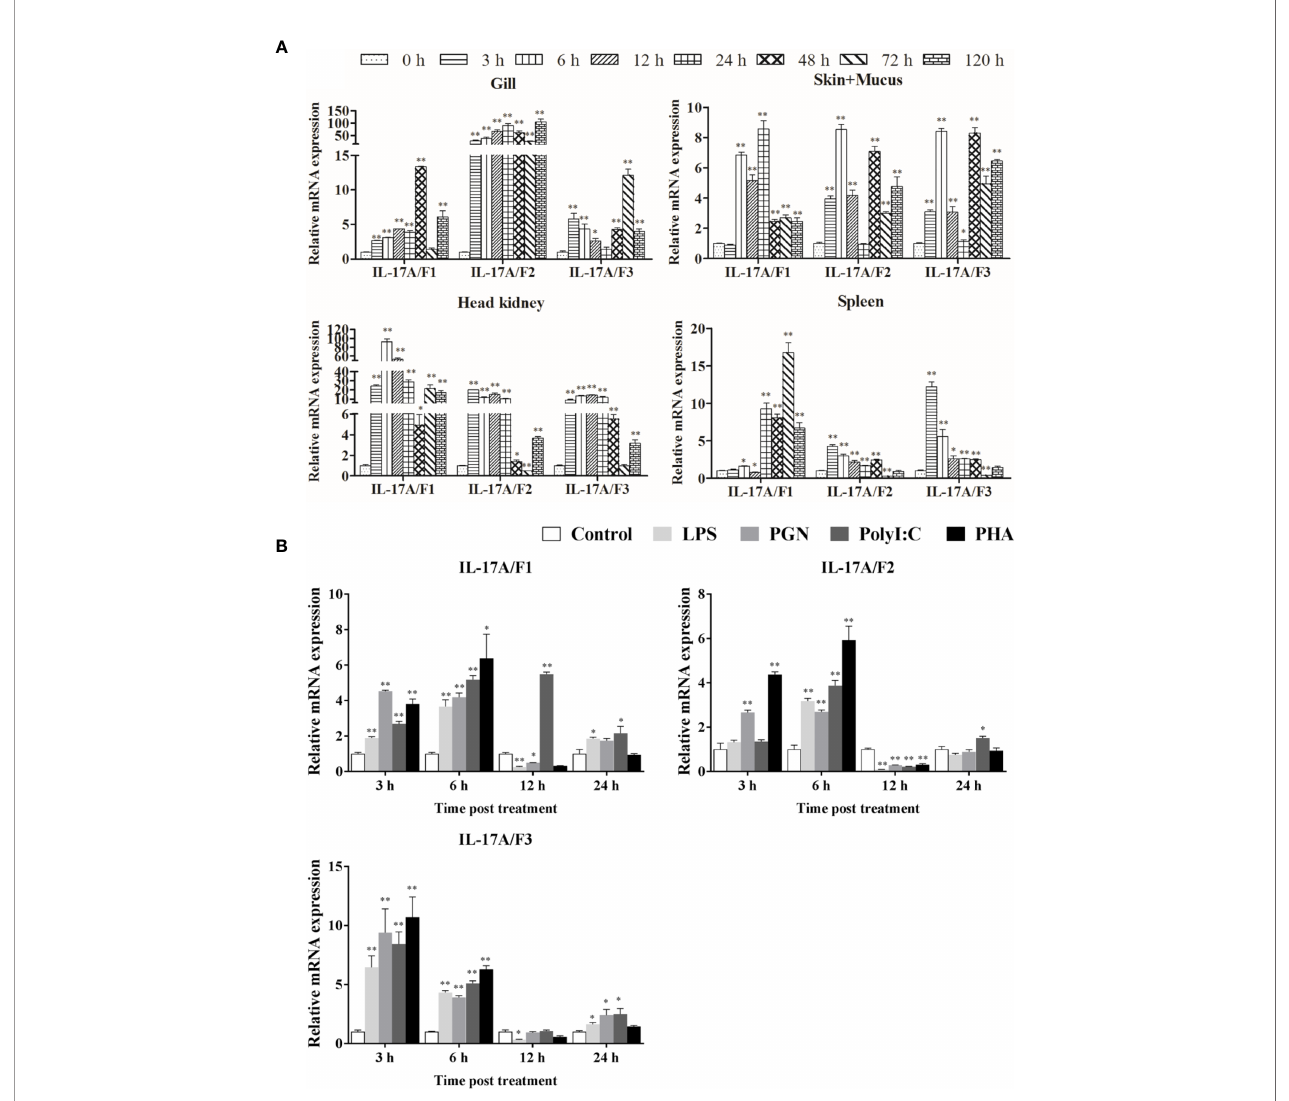
FIGURE 5 | Pf _IL-17A/F1, 2 and 3 mRNAs can be induced after the infection of bacteria and the stimulation with stimulators. (A) The changes of relative expression levels in the gill, skin+mucus, head kidney and spleen of yellow cat fi sh after challenge of Edwardsiella ictaluri . Columns and deviation bars represent the means for each treatment ( n = 3) and the standard errors of the means, respectively. (B) The changes of expression levels in PBLs of yellow cat fi sh after stimulation with LPS, PGN, Poly I:C and PHA. The PBLs were isolated from fi ve individuals of yellow cat fi sh and were mixed equally, and the pooled sample was further divided into 20 experiment units for different experimental treatments. Columns and deviation bars represent the means for each treatment ( n = 3) and the standard errors of the means, respectively. Signi fi cant differences at different time points after challenge compared to the control are indicated by asterisks (* P < 0.05, ** P <